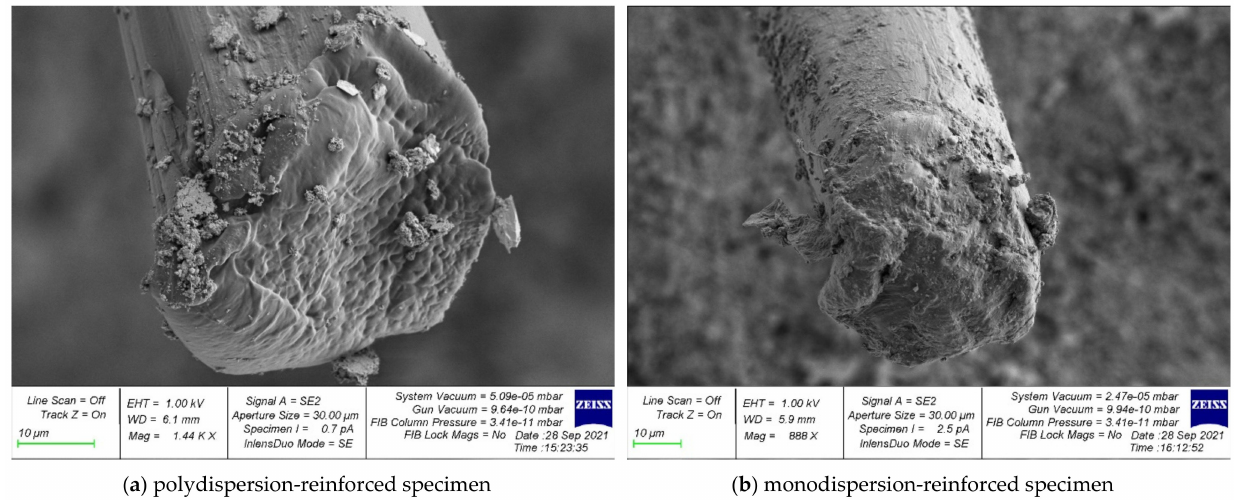
Figure 9. Surface analysis of broken